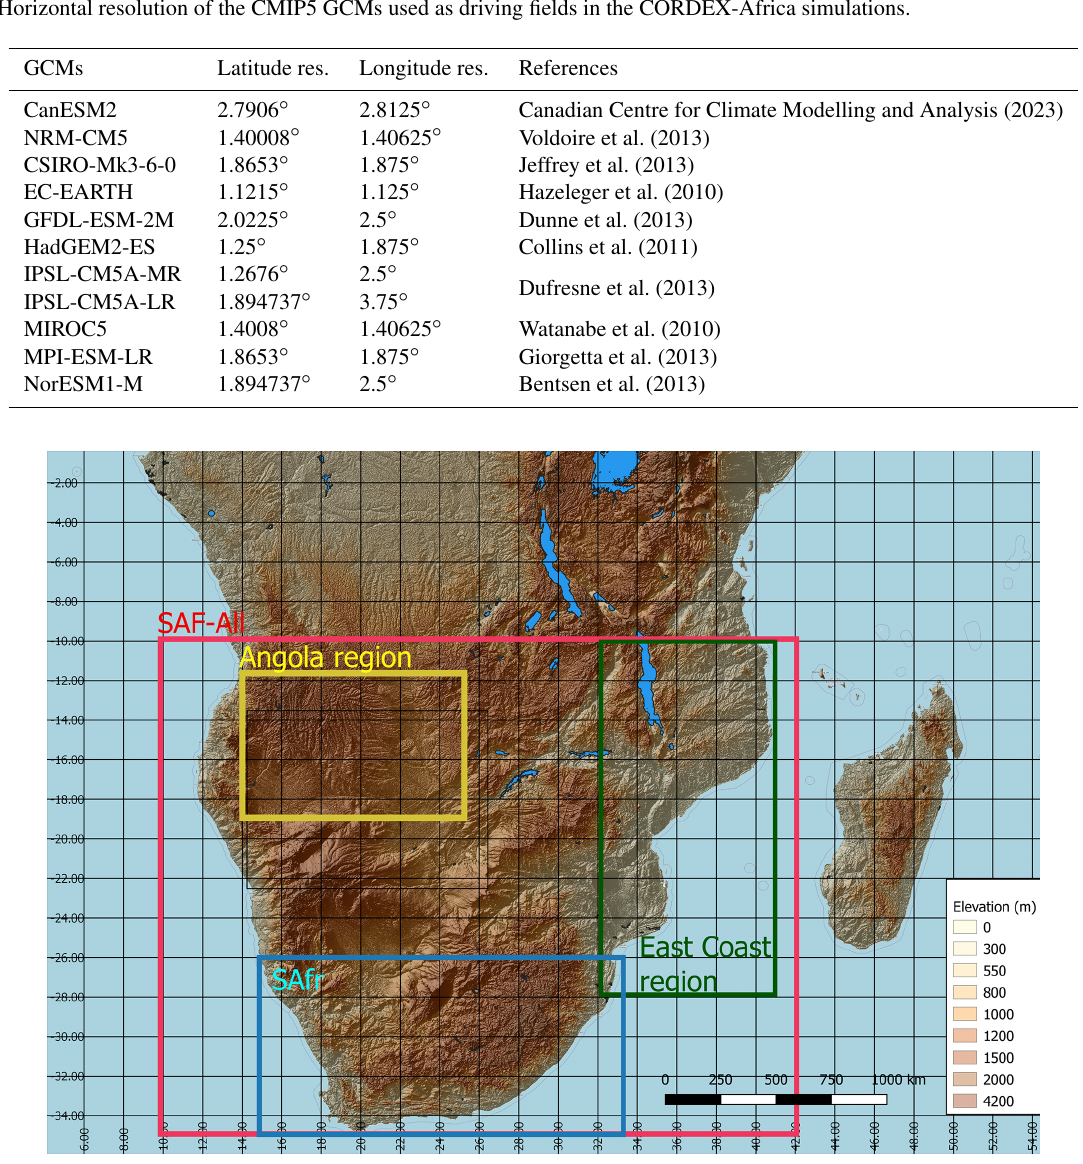
Figure 2. Study region and subregions over southern